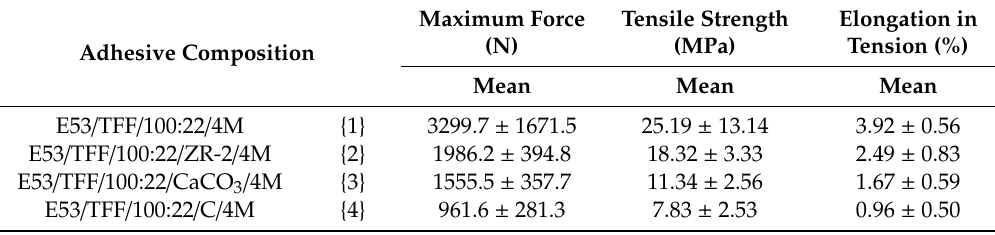
Table 11. Strength test results of the adhesive compositions from the E53 / TFF / 4 month